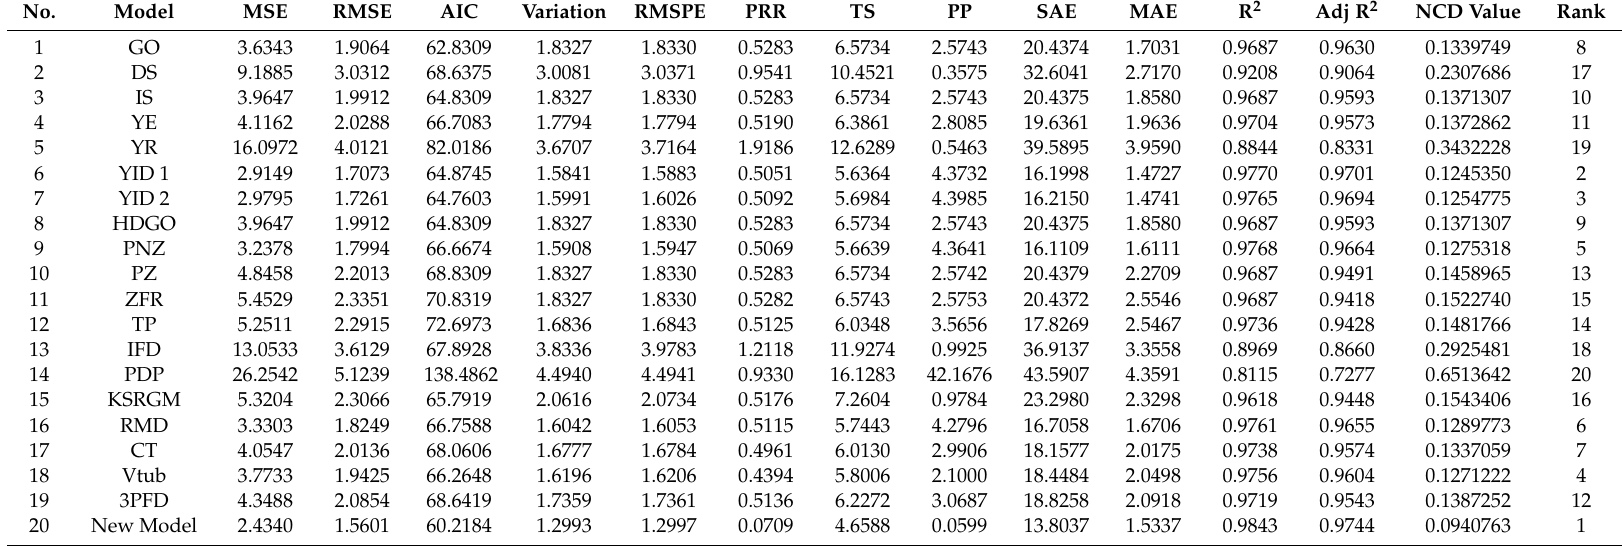
Table 4. Results of criteria and NCD values for comparison with dataset